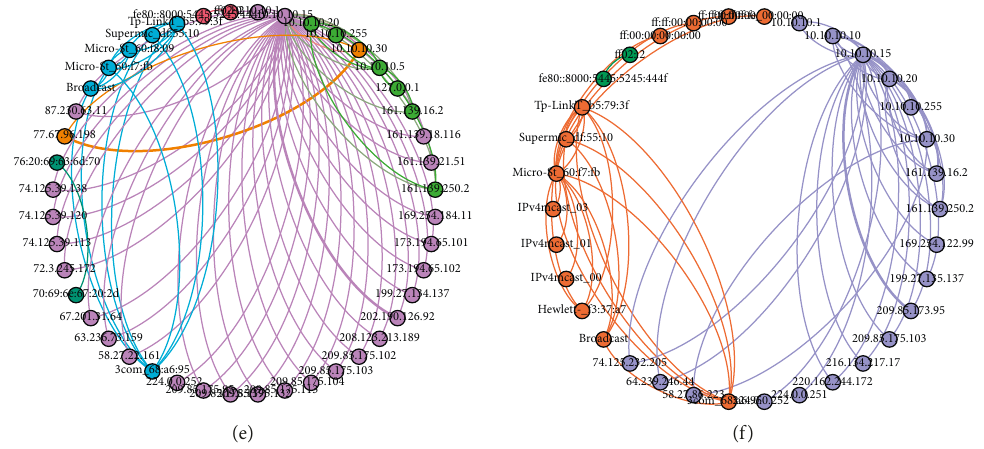
Figure 12: Snapshot of the node-to-node traffics during the attack.